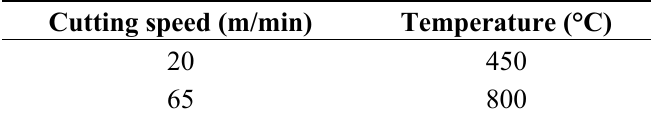
Table 6. Estimated temperatures during machining of Ti-55531 using thermistors. Tool “A”, rake angle 20°.